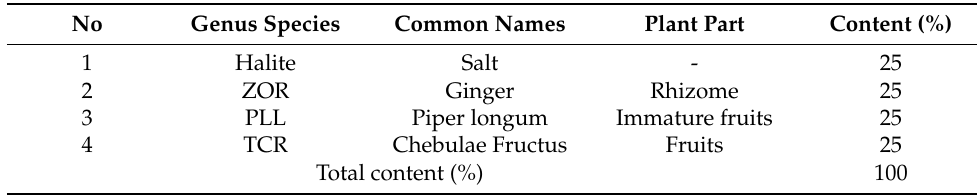
Table 1. Components of